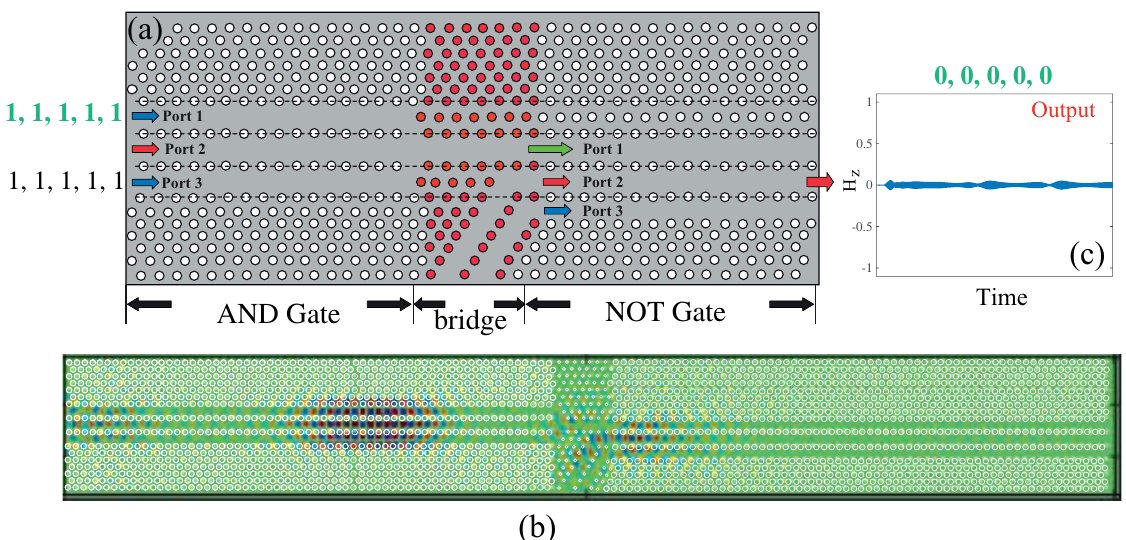
Figure 8. The same as in Figure 7, but the output magnetic field H z is displayed after injection of “1” and “1” input signals into the Ports 1 and 3, respectively. ( a ) Output signal from the AND logic gate is injected into Port 1 of the NOT logic gate; ( b ) magnetic field distribution of the signal pulses in the NAND logic gate; ( c ) magnetic field H z of the received signal. Reprinted from Ref.